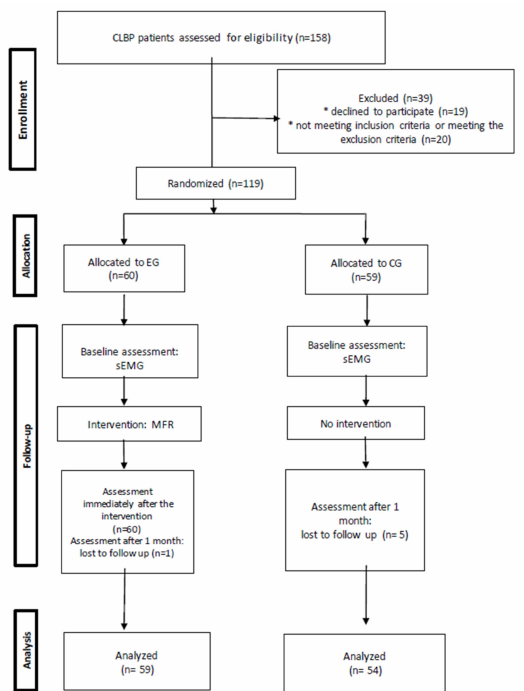
Figure 1. The study flow diagram. CLBP—chronic low-back pain, EG—experimental group, CG— control group, sEMG—surface electromyography, MFR—myofascial